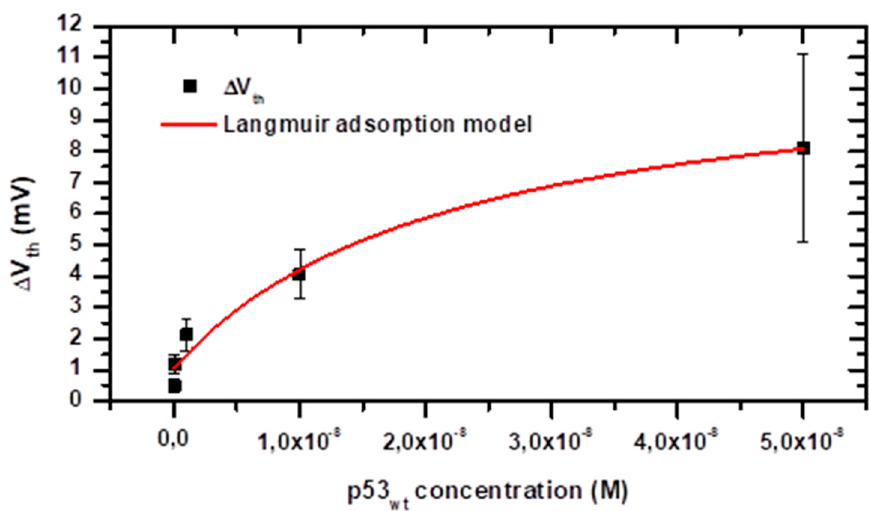
Figure 7. Mean threshold voltage (V th ) changes as a function of the p53 wt concentration in PBS 100 mM pH 8.0 solution. The error bars represent the data standard deviation. The data have been fitted by an adapted version of the Langmuir adsorption model including an o ff set to take into account the blank signal (see text). The parameters extracted by fitting the experimental data according to the Langmuir adsorption model (continuous red line; R 2 = 0.96) are: o ff set ∆ V 0 = 1.0 ± 0.4 mV, ∆ V thmax = (10.1 ± 2.2) mV, K D = (2.2 ± 1.3) × 10 − 8 M.